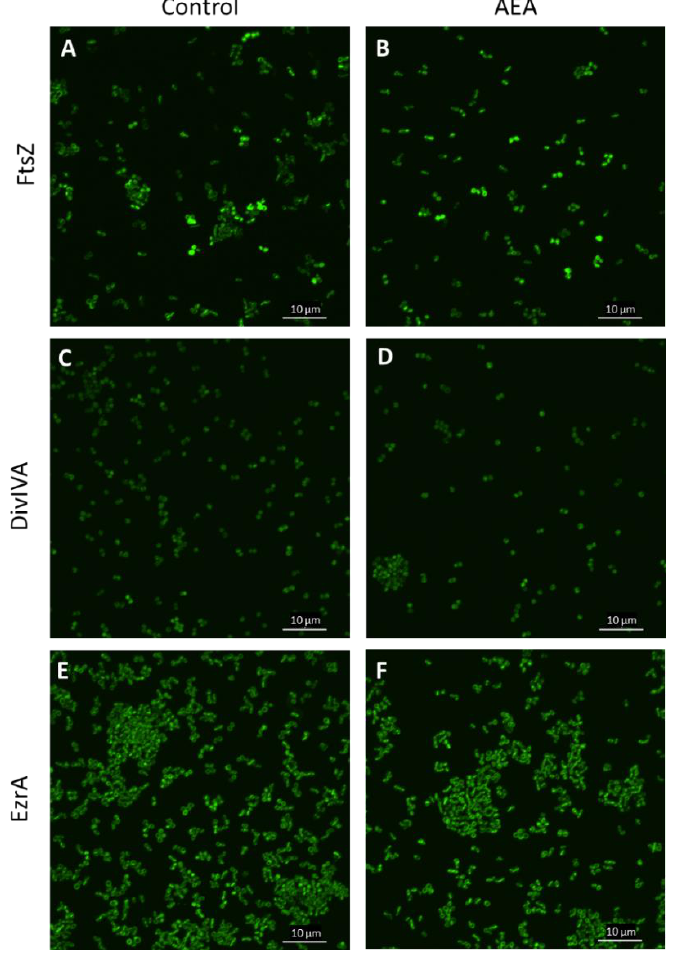
Figure 9. AEA did not interfere with the formation of the FtsZ Z-ring. ( A – E ). LH607 with inducible FtsZ-GFP (SA103) ( A , B ), LH607 expressing inducible DivIA-GFP (SA356) ( C , D ), or LH607 expressing EzrA-GFP (SA353) ( E , F ) were exposed to 50 μM IPTG for 2 h to induce the expression of the respective GFP fusion proteins and then incubated in the absence or presence of 50 μg/mL AEA for 2 h and the green fluorescence visualized by spinning disk confocal microscopy using the 488 nm excitation laser and the green filter. The bars represent 10 µm.